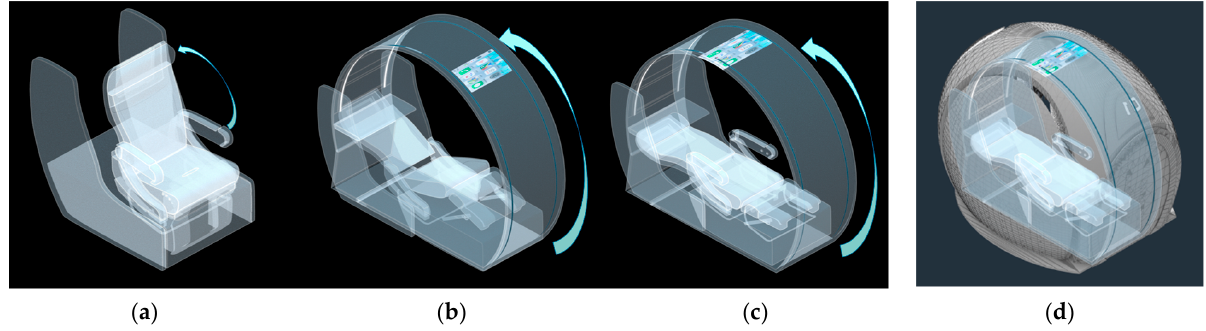
Figure 8. Isometric views illustrating the interactivity between the recliner seat and the projected screen to maintain a suitable field of vision by changing the angle of inclination of the smart seat: ( a ) Working/meeting position, ( b ) Relaxation/meditation position, ( c ) Napping position, and ( d ) Pod’s closed form showing the interior view (design by the authors). In terms of fabrication, tech-